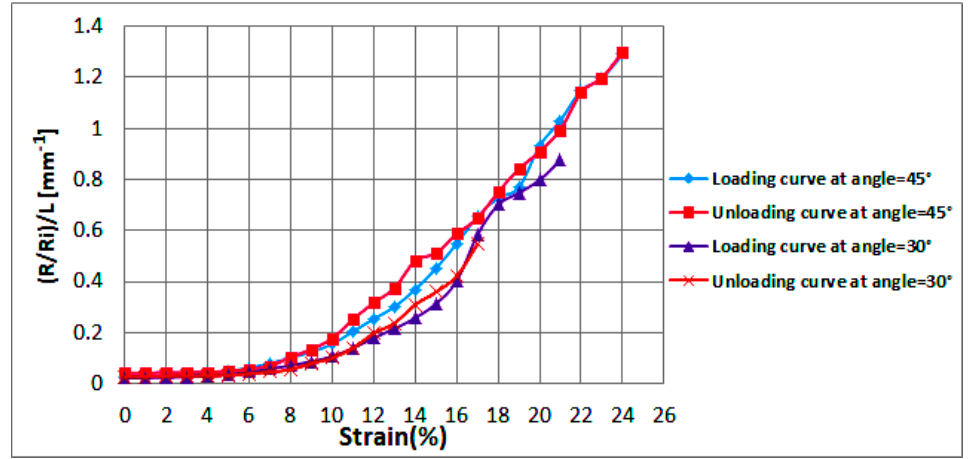
Figure 14. Average normalized resistances per unit length of two horseshoe samples at various angles as the applied strain increases (loading) and decreases (unloading).